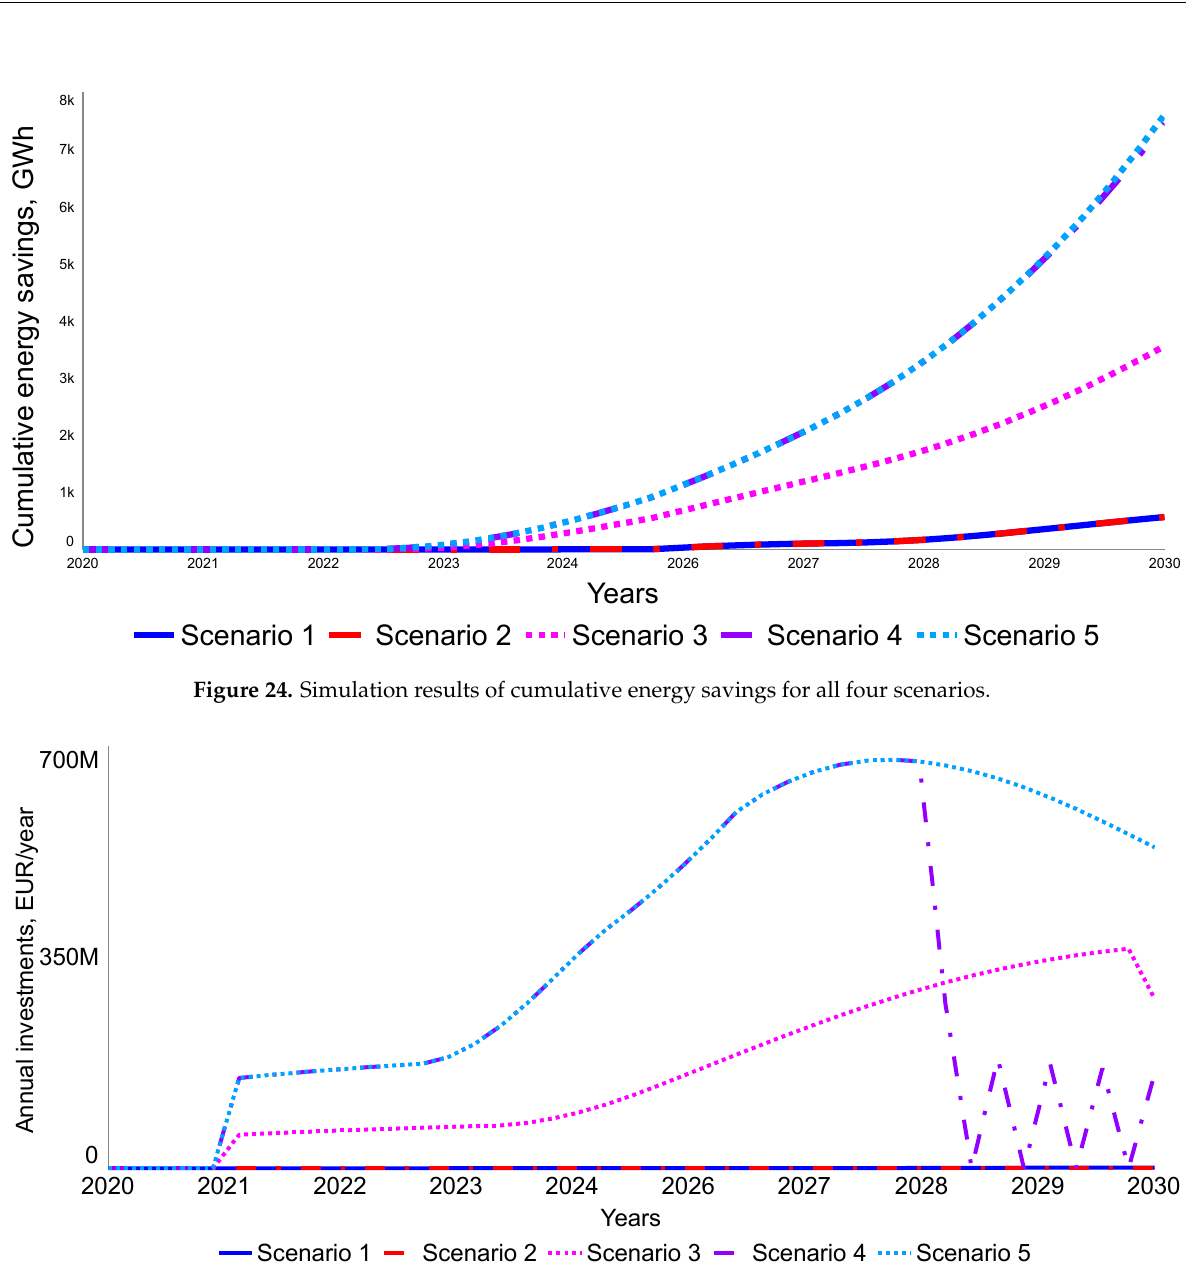
Figure 25. Simulation results for annual costs for each scenario. Scenario 1 results show that, by the current policy mechanisms, the actual cumulative savings in the housing sector will be 570 GWh by 2030, and the total cumulative costs will be 1.15 million EUR. The same results are reached in Scenario 2 and show that the result will not change even when multiplying the investment but not changing the policy tools. Scenario 3 shows that even by having the same amount of investments as in Scenario 1 and combining it with the targeted policy tools, the improvement could be reached. The cumulative savings will increase to 3600 GWh, the total cumulative costs will be 715 million EUR, and the annual investment rate will gradually increase over the